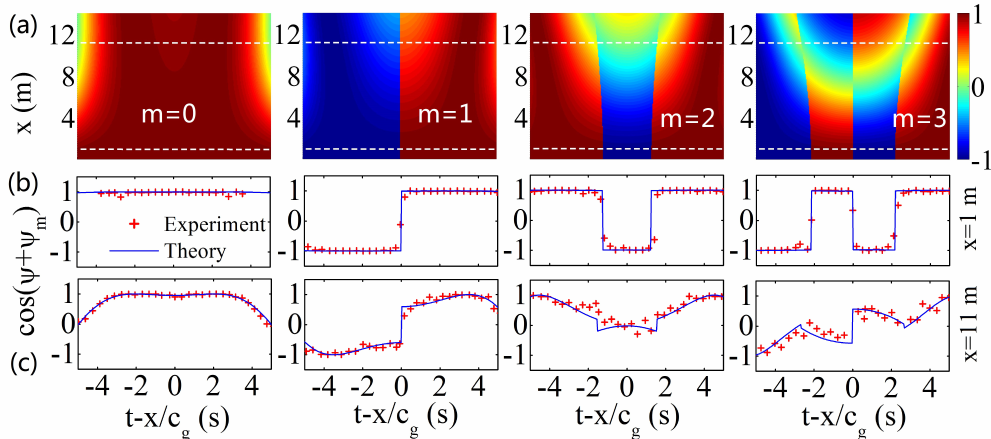
Figure 10. The carrier-envelope phase of the non-chirped HG pulses demodulated from the measured water surface elevation variation with time, with a 0 = 6 mm, t 0 = 2.5 s, and C = 0. The envelope phase is presented as a cosine function of time. ( a ) Two-dimensional phase map calculated from Equation (32) for different order of m . ( b , c ) The envelope phase profiles at x = 1 m ( b ) and x = 11 m ( c ). The blue curves in ( b , c ) correspond to the theory, while the red scattered dots denote the experiments.